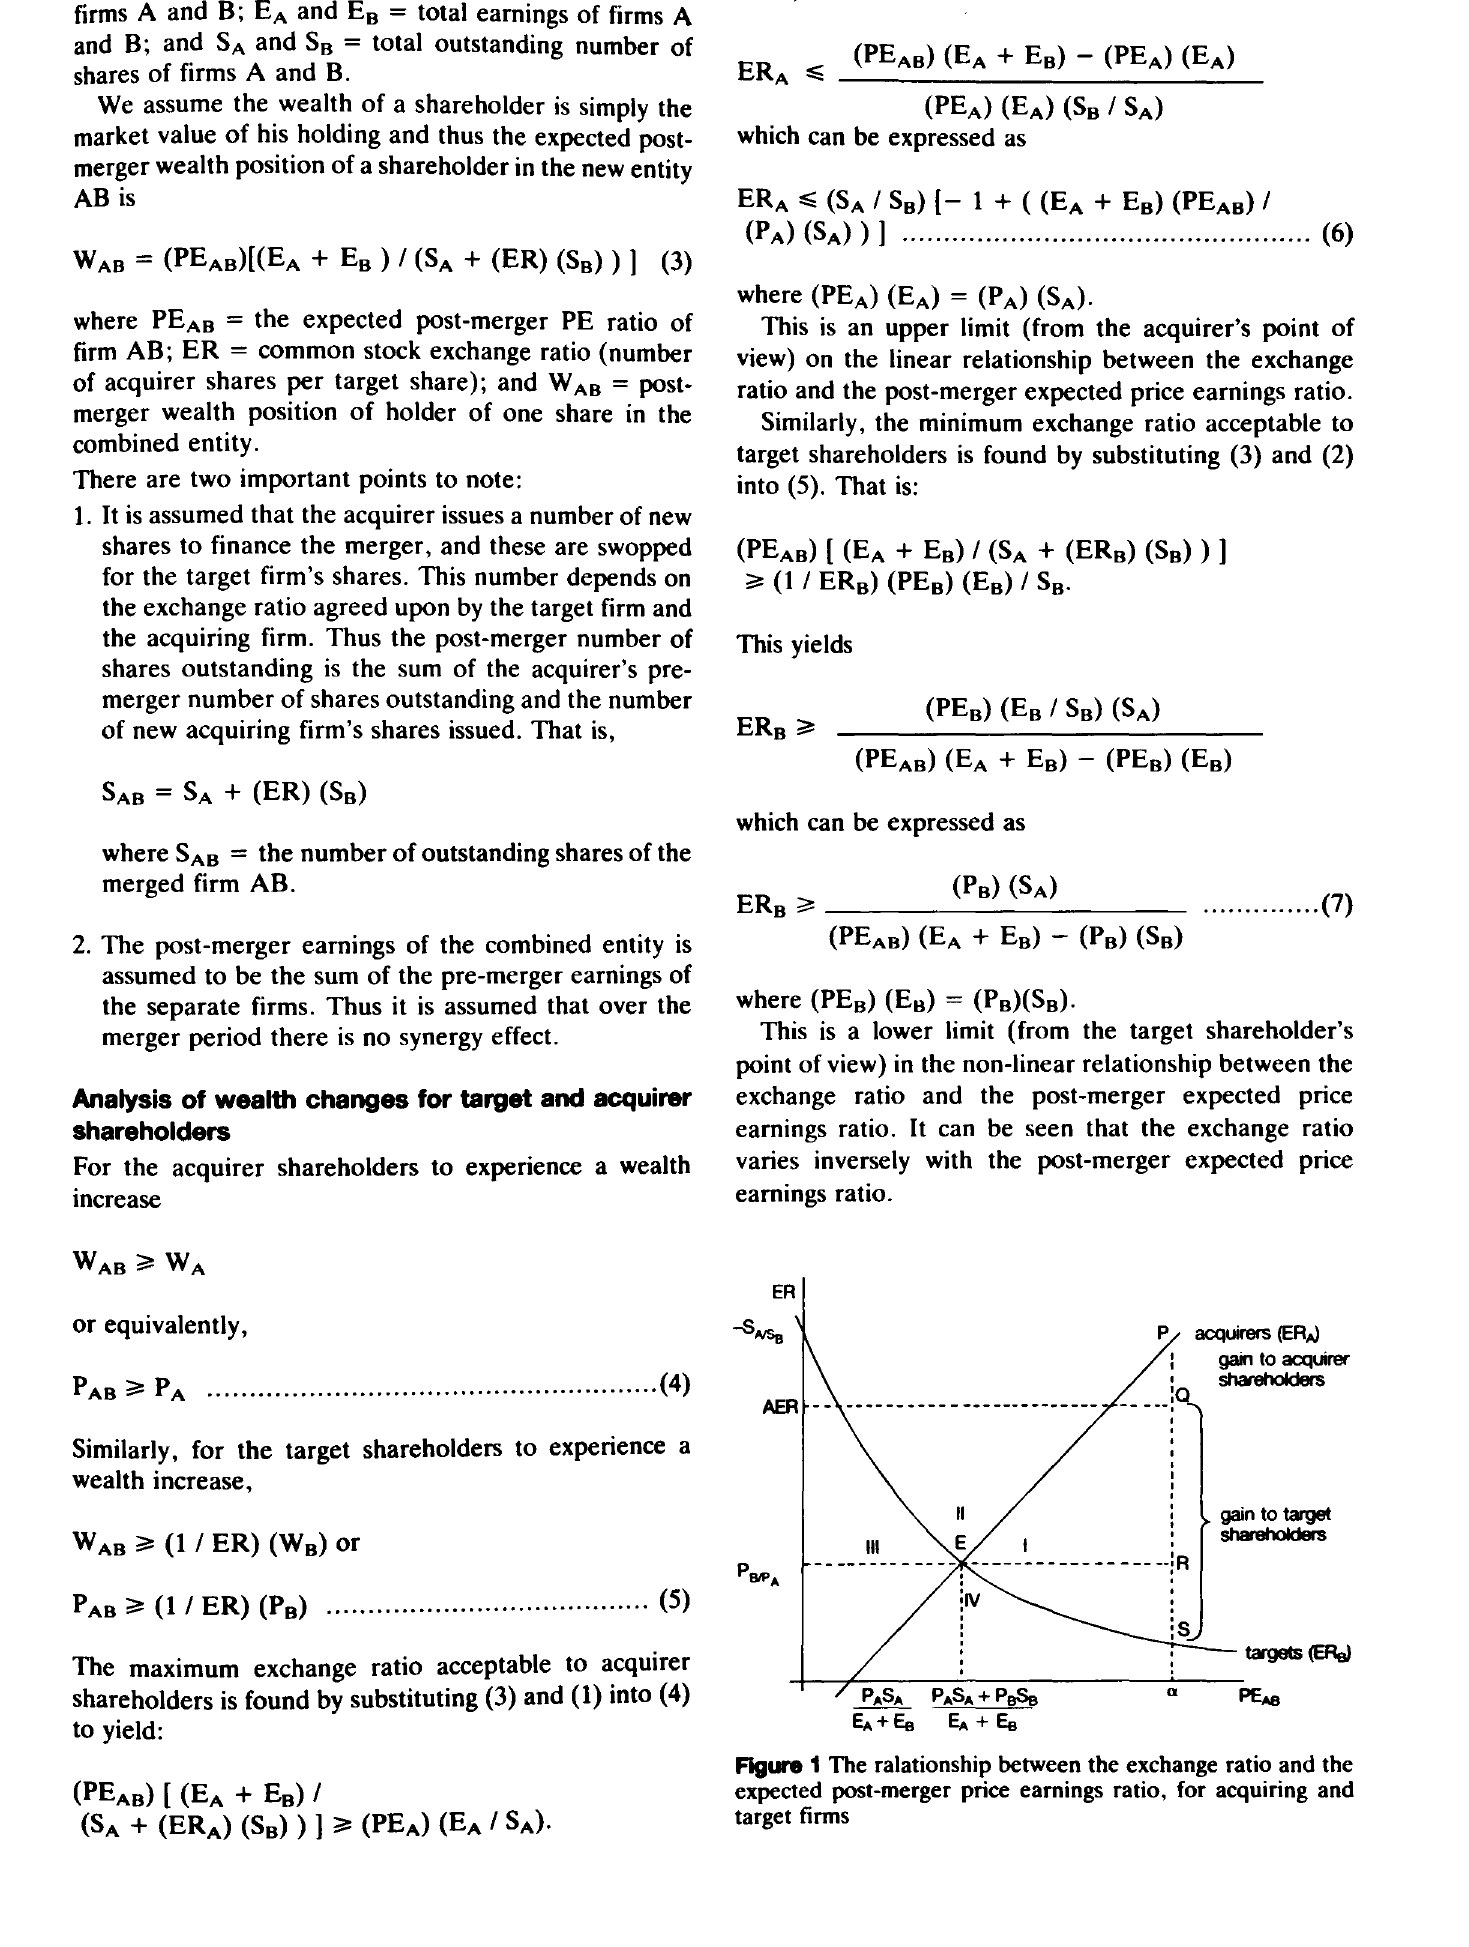
Figure 1 The ralationship between the exchange ratio and the expected post-merger price earnings ratio, for acquiring and target